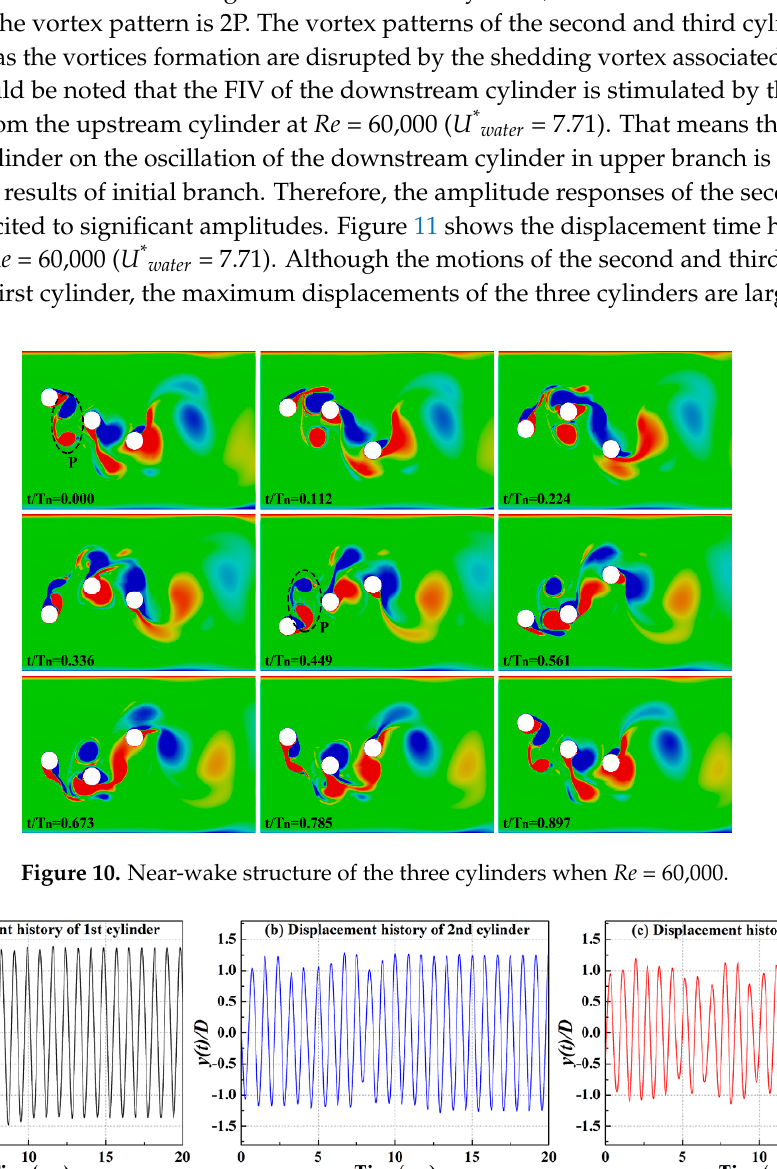
Figure 8. Near-wake structure of the three cylinders when Re = 30,000.